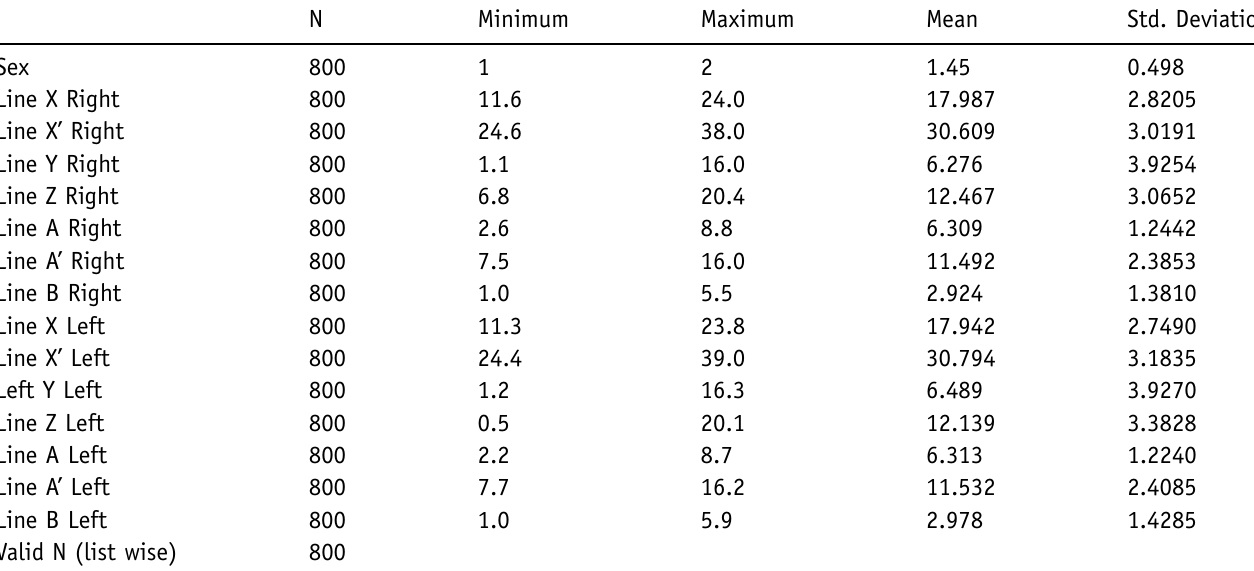
Table I. Descriptive